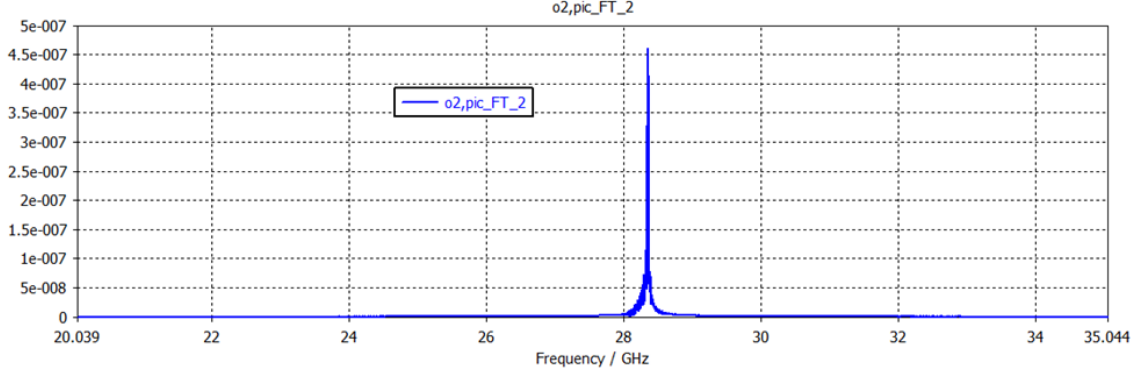
Figure 17. Frequency spectrum of the output signal.